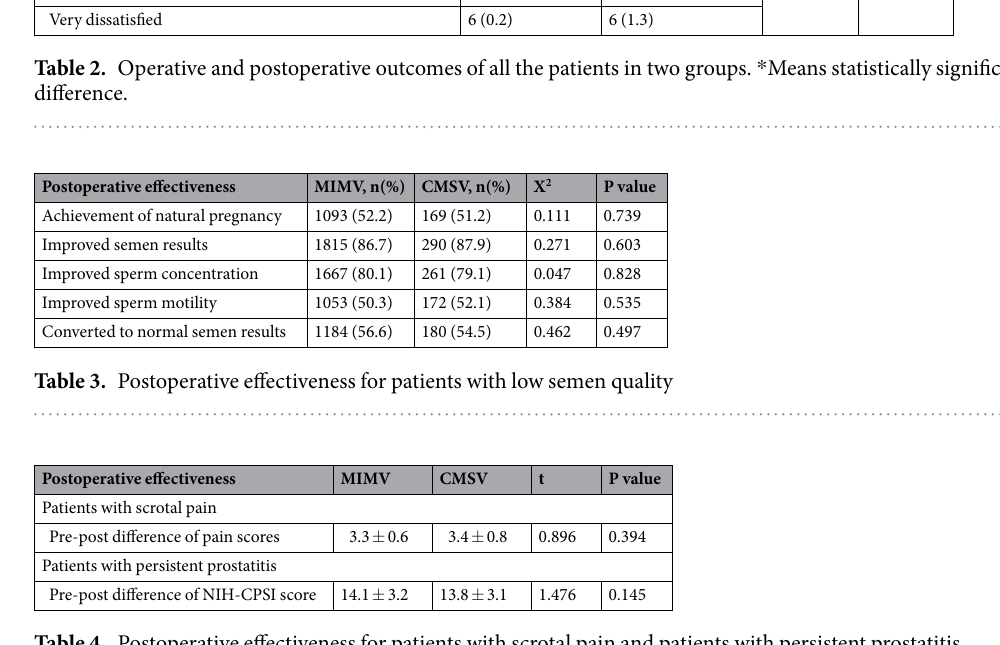
Table 4. Postoperative effectiveness for patients with scrotal pain and patients with persistent